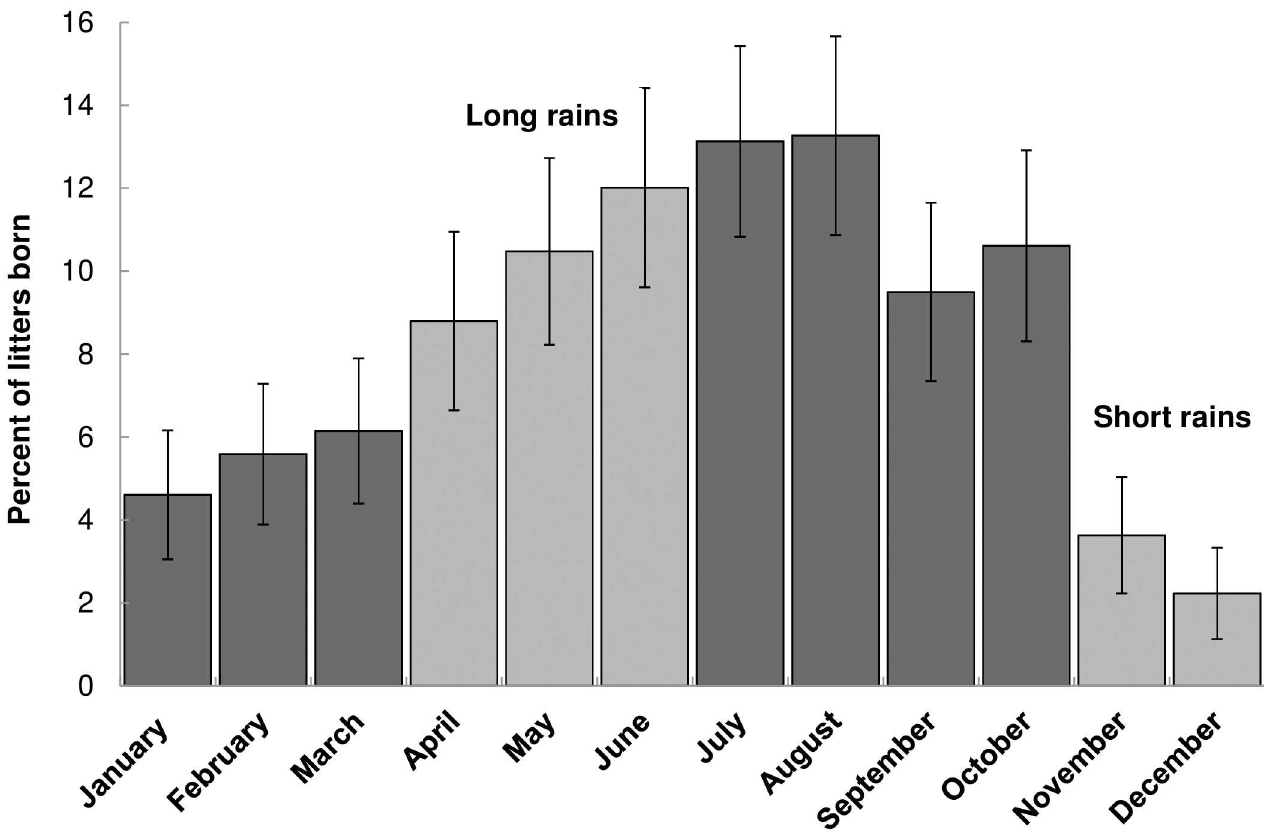
Fig 4. Percentage of litters of puppies born ( n = 716) throughout the study in each month of the year. Lighter colored bars (March-May and November-December) indicatetypical rainy season conditions. Dark colored bars (January-February and June-October) indicatetypical dry season. Error bars represent 95%